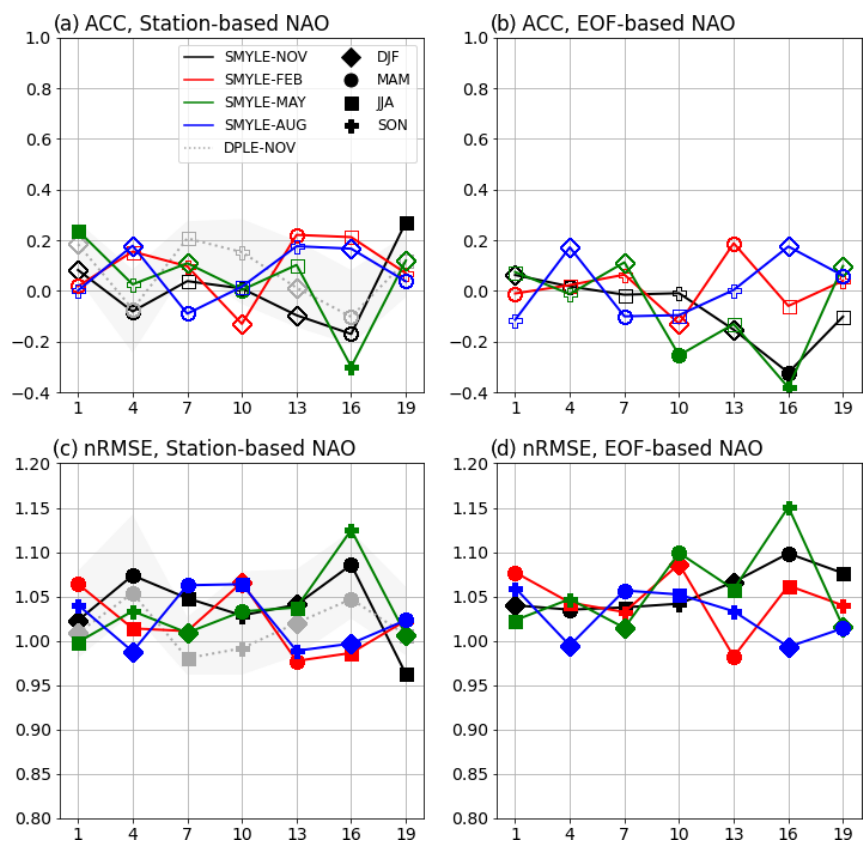
Figure 7. Anomaly correlation coefficient (ACC; a, b ) and nRMSE (c, d) for NAO as a function of initialization month and target season. Results are shown for both station-based ( a, c ; computed as the normalized SLP difference between model grid cells nearest to Lisbon, Portugal and Reykjavik, Iceland) and EOF-based ( b, d ; computed as the PC time series of the first EOF of SLP in the domain 20–80 ◦ N, 90 ◦ W–40 ◦ E) seasonal NAO. Filled symbols in panels (a) and (b) indicate significant ACC scores ( p < 0.1). Scores from 40-member DPLE- NOV are shown in dashed grey, with grey shading giving the 90% confidence bounds obtained from 100 resamplings (across members) of 20-member DPLE-NOV. The verification dataset is